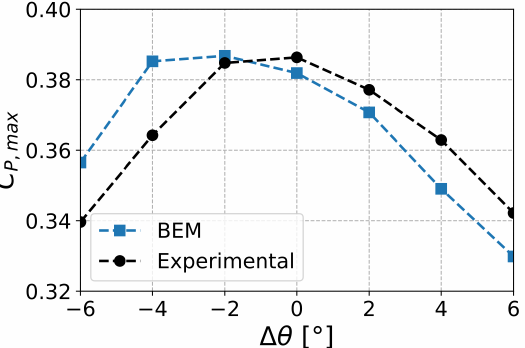
Figure 10. Maximum C P at variable unbalanced pitch for both experiments and BEM simulations for θ = 2 ◦